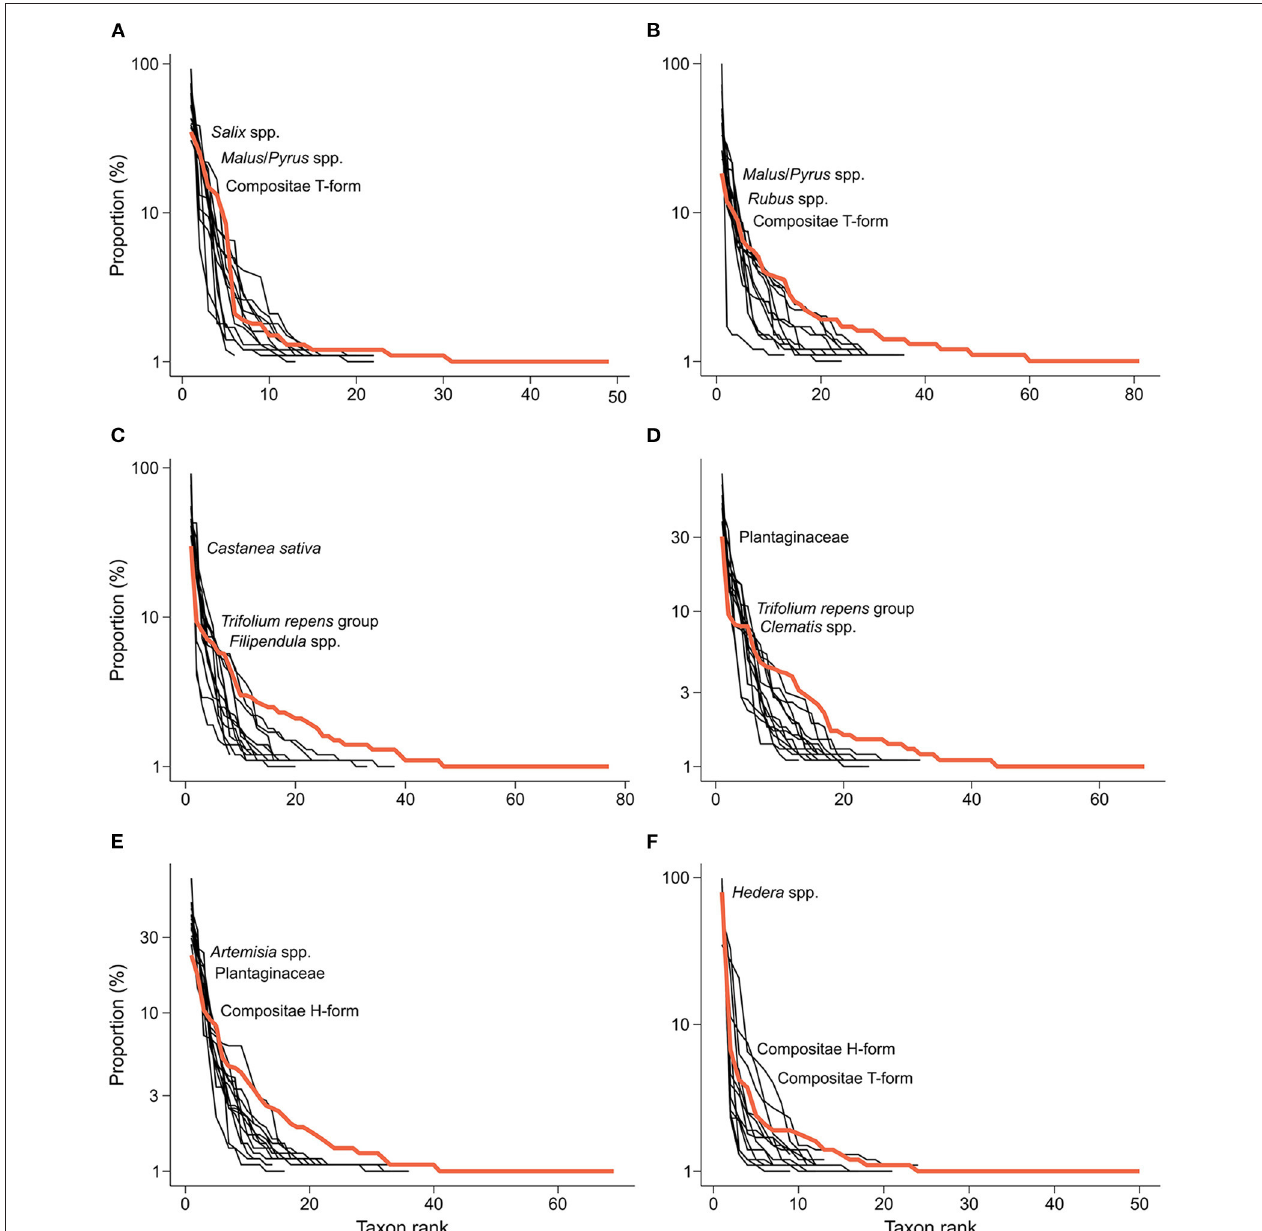
FIGURE 2 | Rank abundance plots showing the relative proportion of the taxa found in pollen samples collected in (A) April, (B) May, (C) June, (D) July, (E) August, and (F) September of 2019 and 2020. Black lines represent single sampling locations, while colored lines represent the average of all locations for each sampling month. Species are ranked on the x-axis from left to right from the most to least abundant. Y -axis is log-transformed to improve clarity.